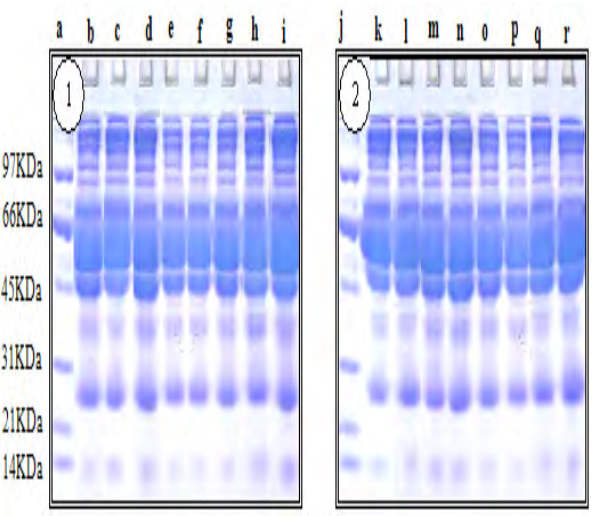
Figure 5: SDS-PAGE of serum proteins from rats at 21 days post oral treatment (panel 1) or intraperitoneal injection (panel 2) of baculovirus: control males (lanes b and k), control females (lanes c and l), SlNPV exposed males (lanes d and m), SlNPV exposed females (lanes e and n), AcMNPV exposed males (lanes f and o), AcMMPV exposed females (lanes g and p), AcAaIT exposed males (lanes h and q), AcAaIT exposed females (lanes i and r). The sizes of molecular weight standards (lanes a and j) are indicated to the left of panel 1. In terms of serum glucose levels (Table 7), male rats that were orally exposed to the baculoviruses did not show any significant differences. In contrast, female rats showed 36.6% and 16.4% higher glucose levels when exposed orally to SlNPV or AcMNPV, respectively; and 40.2% lower levels when orally exposed to AcAaIT. Following intraperitoneal injection, male rats showed no significant differences in glucose levels; whereas female rats showed 27.3% and 33.9% decreases following injection with SlNPV and AcAaIT,